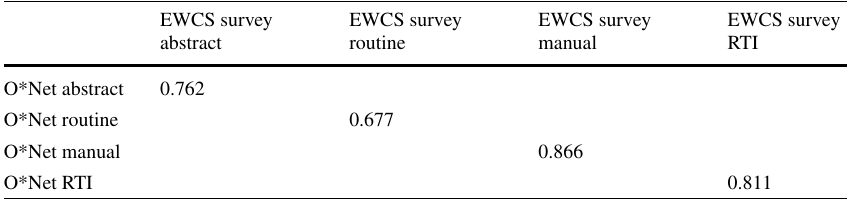
Table 1 Correlation between EWCS and O*Net. Sources : author’s analysis from EWCS and O*Net